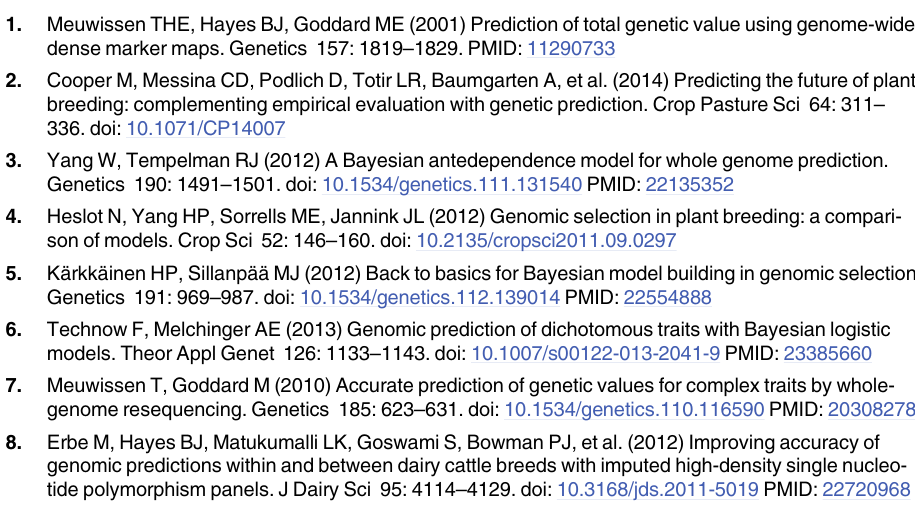
S1 Table. Accuracy of grain yield predictions of test DH lines with increased error in prior parameters. S1 Dataset. SNP genotypes and trait phenotypes of synthetic maize doubled haploid lines. The data set is a representative example of the 50 synthetic data sets used in the study. (CSV) S1 Fig. Simulated development of total and senescent leaf area. The early, intermediate and late maturing genotypes had a total leaf number (TLN) of 6, 14.5 and 23, respectively. The val- ues for the other three traits were 750 for AM, 1.6 for SRE and 1150 for MTU and in common for all genotypes. The full and dotted vertical lines indicate the end of the 2012 and 2013 grow- ing season, respectively. S2 Fig. CGM-WGP vs. GBLUP prediction accuracy in 50 synthetic data sets. S3 Fig. Relationship between physiological traits and total grain yield. Data shown are a random sample of 1000 genotypes from a representative example replication. S4 Fig. Distribution of simulated grain yield in 2012 and 2013 environments. The grey lines indicate the performance of specific genotypes in both environments. Data shown is from a representative example